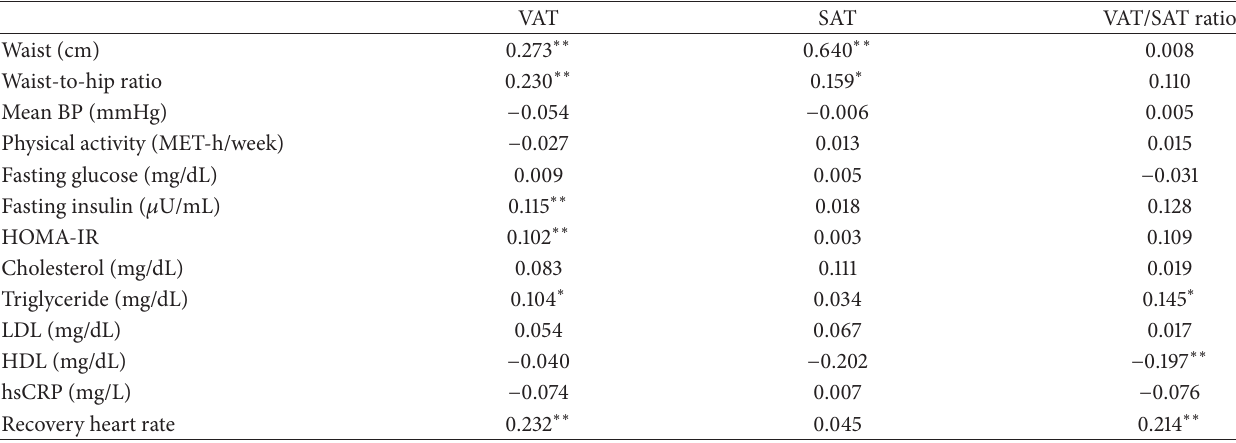
Table 2: Correlation coefficients between fitness level (recovery heart rate) and cardiometabolic characteristics and abdominal adiposity (VAT, SAT, and the VAT/SAT